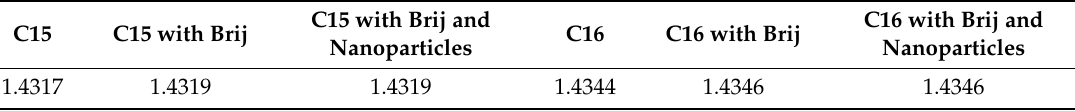
Table 4. Refractive indices of investigated mixtures at 20.4 ◦ C.